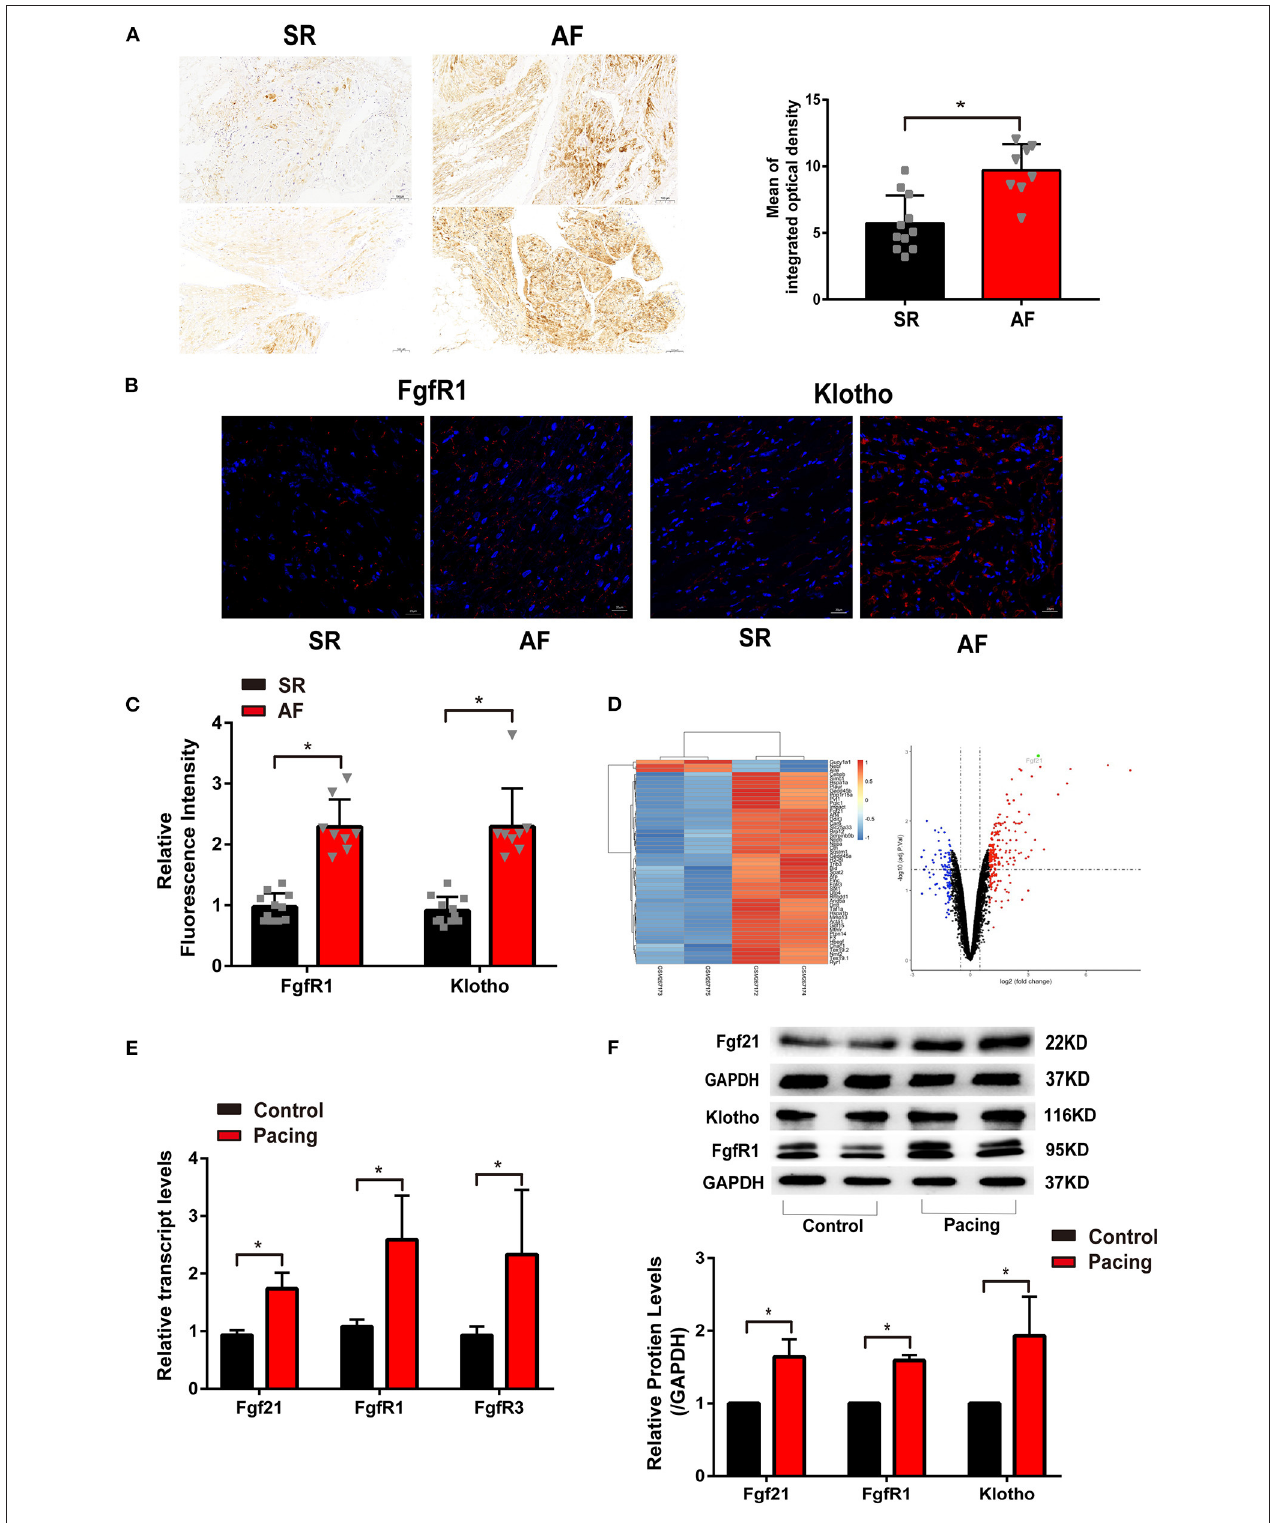
FIGURE 1 | The level of fibroblast growth factor 21 (Fgf21) increased in the atrial tissue of patients with atrial fibrillation (AF) and cell models of atrial remodeling. (A) Representative immunohistochemistry image of Fgf21 in sarcoplastic reticulum (SR) and AF patients. Three sections per tissue sample were prepared, and three random pictures were taken from each section. IOD, integrated optical density. (B) Representative immunofluorescence images of FgfR1 and β -Klotho in SR and AF patients. (C) Summary of the relative fluorescence intensity of FgfR1 and β -Klotho in the atrial tissue of SR and AF patients. (D) One clustering diagram and